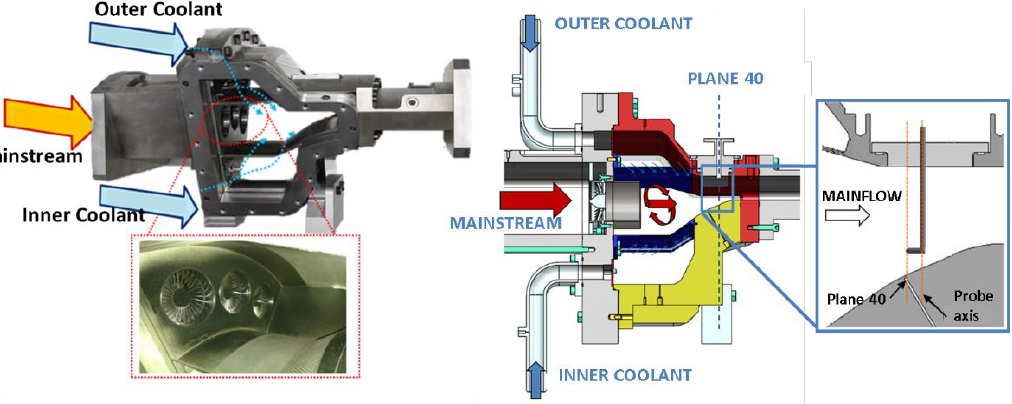
Figure 1. View of the combustor simulator test rig.